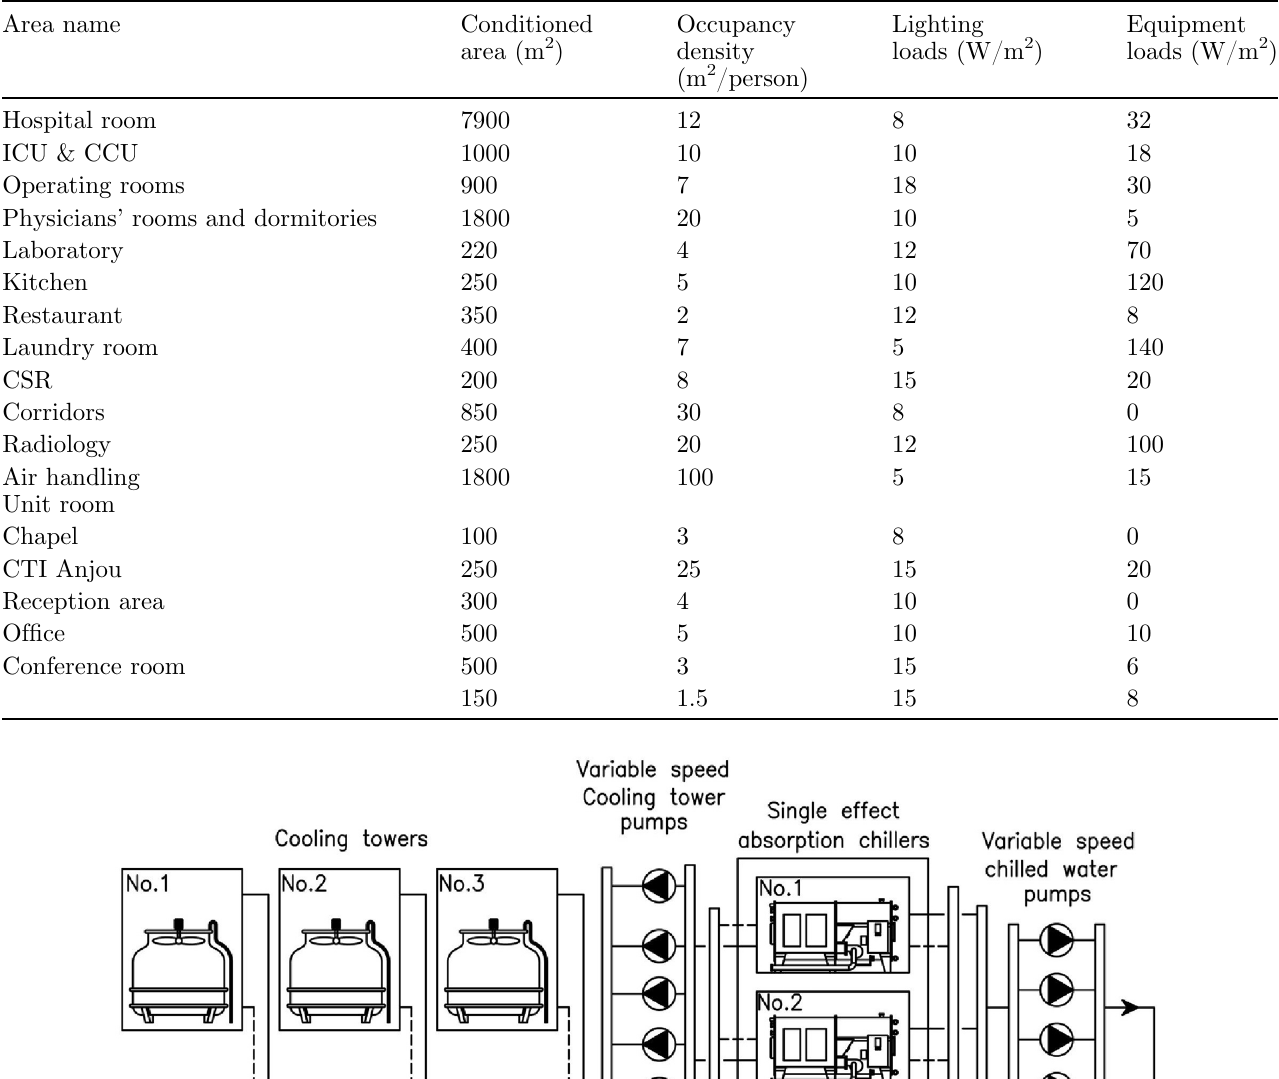
Table 1. Tehran heart hospital building physical attributes.